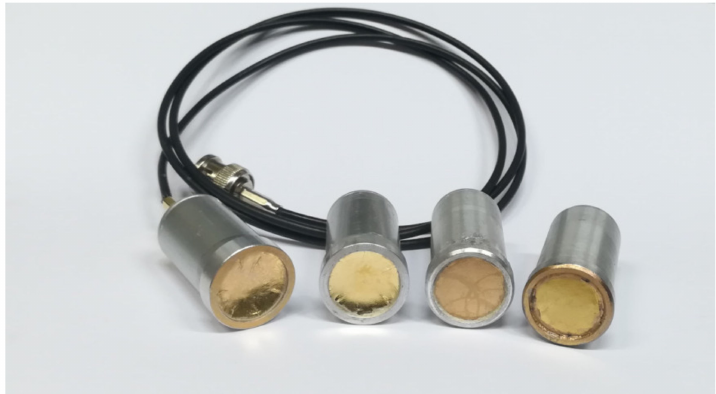
Figure 2. Picture of transducer prototypes, from left to right: HS03 focused (radius of curvature: 22 mm), HS03 focused (radius of curvature: 35 mm), HS06 flat, HS03